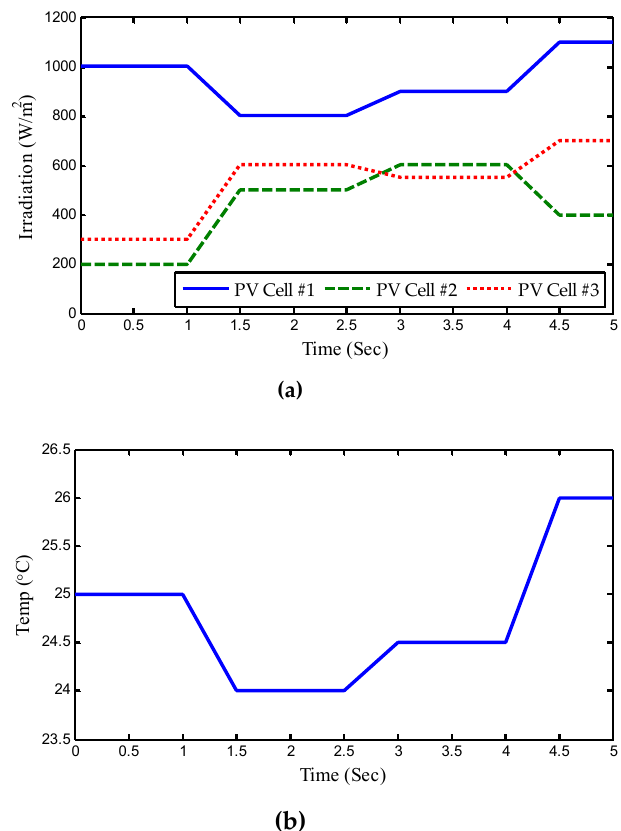
Figure 8. Gradual change in both solar irradiation and temperature. ( a ) Irradiation and ( b ) temperature.